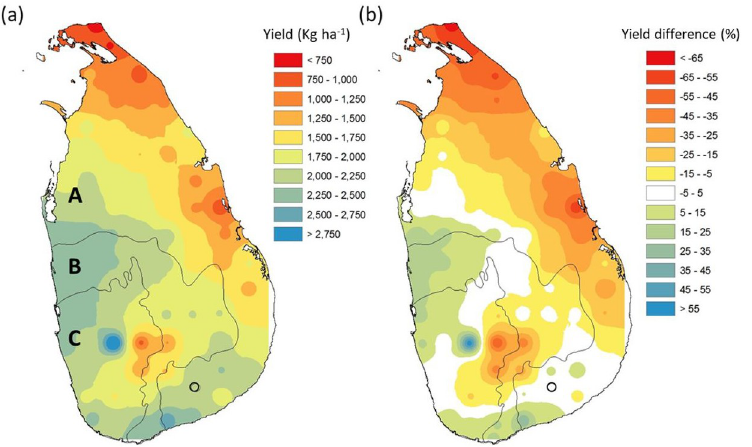
Fig 4. (a) Potential average Proso millet yield of five accessions and (b) yield difference compared to the currently growing area (circled) during 1980–2009 period (the boundary was obtained from https://data.humdata.org/